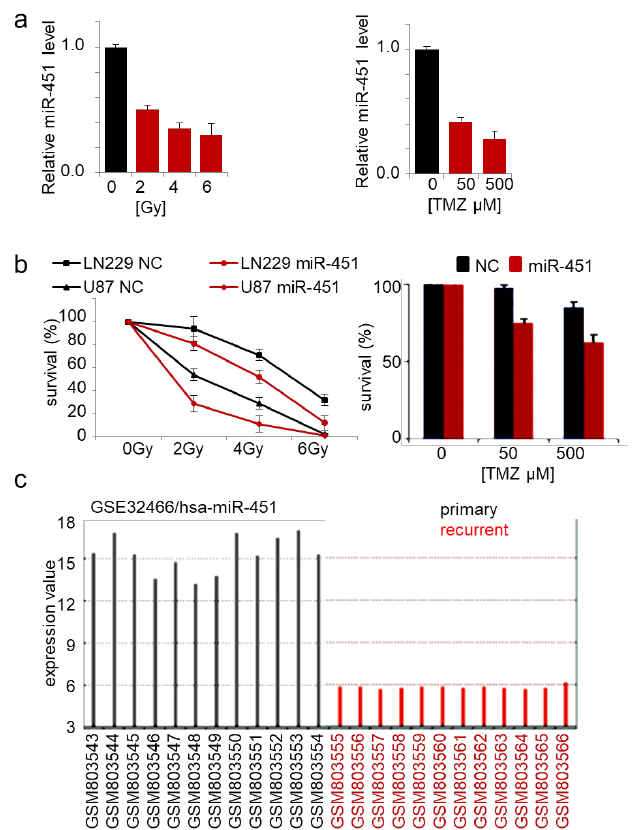
Figure 3. Forced expression of miR-451 sensitizes GBM cells to therapy. ( a ) miR-451 is down-regulated in cells exposed to radiation ( left ) and TMZ treatment ( right ) in GBM cells; qRT-PCR of miR-451. ( b ) miR-451 decreases survival of cells irradiated ( left ) or treated with TMZ ( right ). ( c ) miR-451 is significantly down-regulated in recurrent GBM (source: GEO